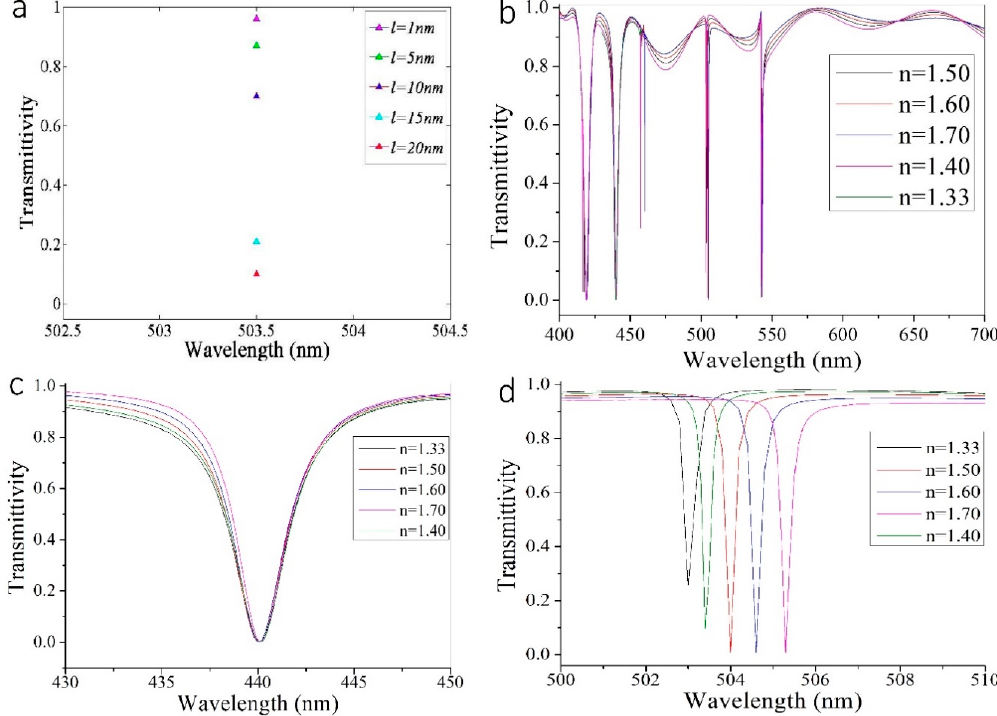
Figure 6. The transmission spectrum for thin layer with a constant environmental refractive index of 1.33. ( a ) The thin layer transmittivity for a constant refractive index of 1.5 and various thicknesses l . ( b ) The broadband transmission spectrum for thin layers with constant thickness l = 90 nm and various refractive indexes. ( c ) The specific transmission spectrum for thin layers with constant thickness l = 90 nm and various refractive indexes within a wavelength range of 430–450 nm. ( d ) The specific transmission spectrum for thin layers with constant thickness l = 90 nm and various refractive indexes within a wavelength range of 500–510 nm.